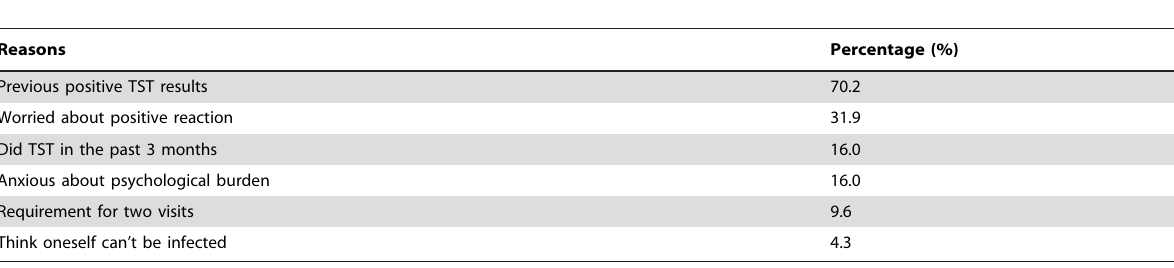
Table 5. Reasons for refusal TST among HCWs (N